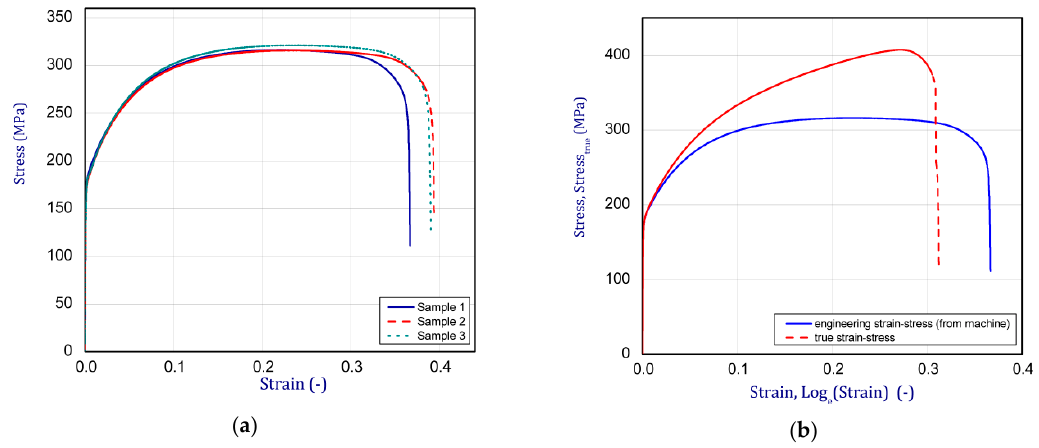
Figure 5. The tensile test characteristics of cold-rolled steel (DC01) ( a ) and transformation into true strain-stress relation ( b ).